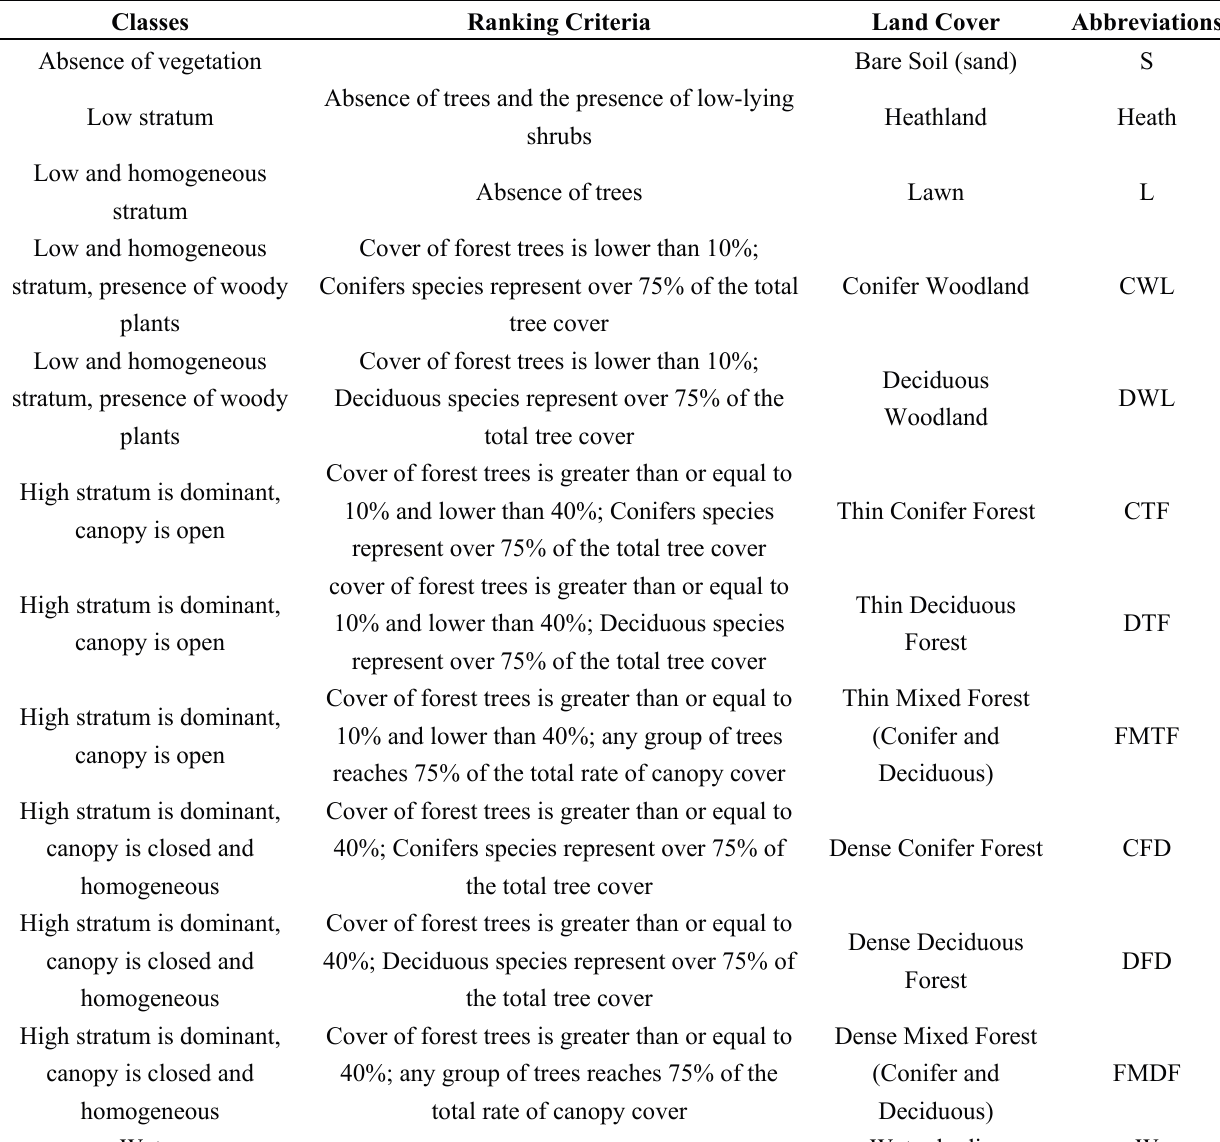
Table 1. List of the different vegetation categories used during the photo interpretation